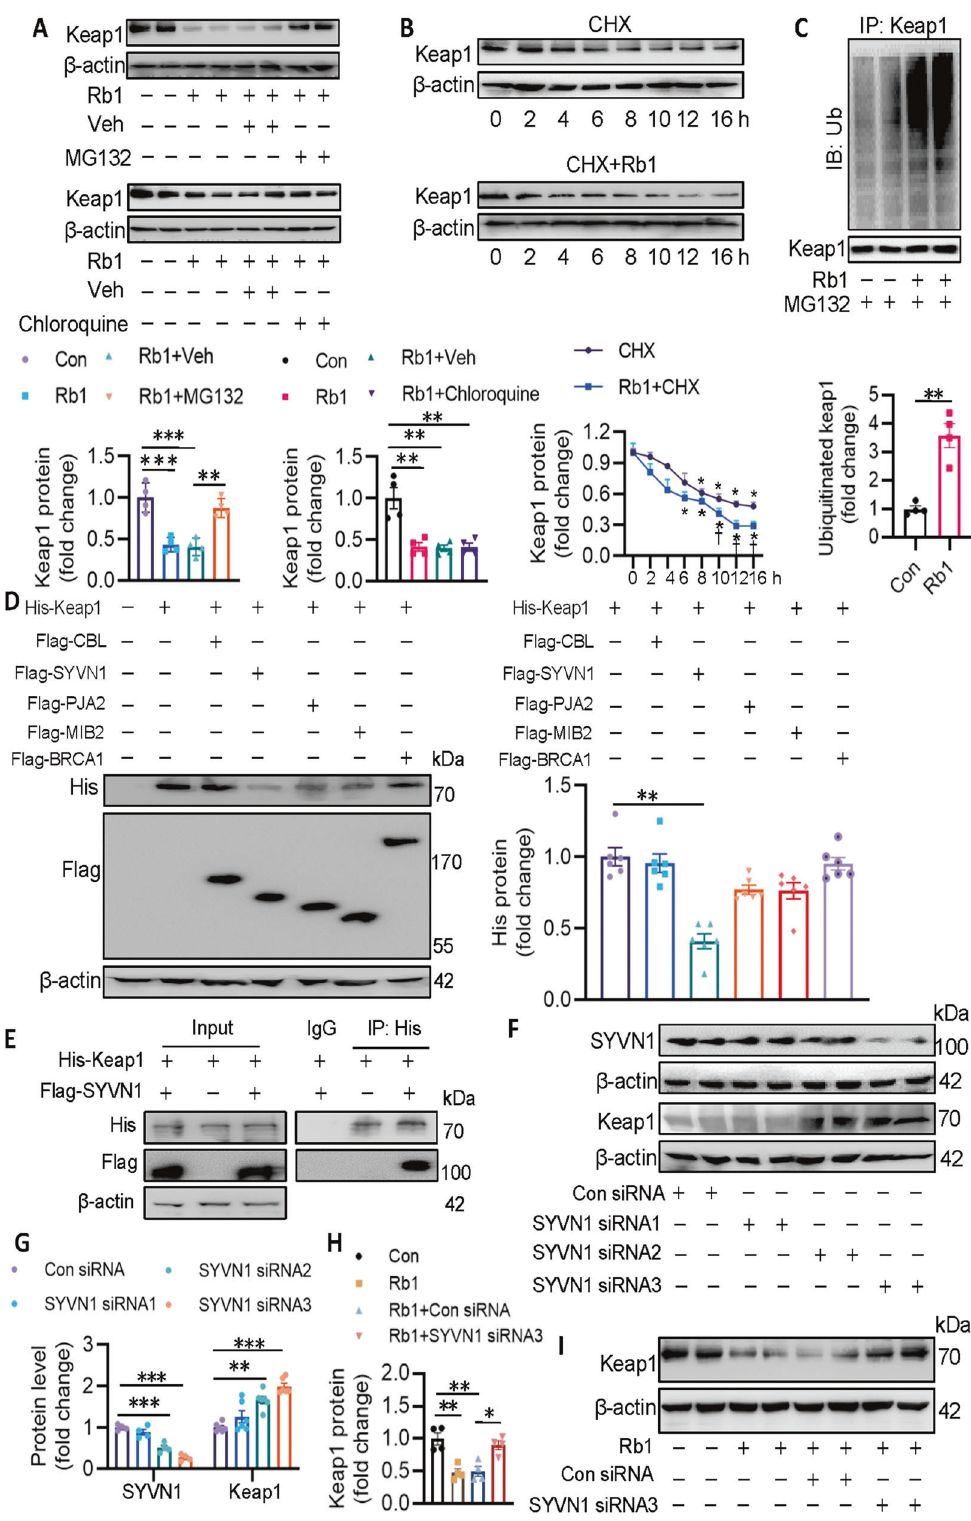
Fig. 5 SYVN1 is identi fi ed as the E3 ligase of Keap1 and mediates its degradation induced by Rb1. A MG132, but not chloroquine, reversed the effects of Rb1 on the protein level of Keap1. B Rb1 accelerated the degradation of Keap1 in the presence of CHX. C Rb1 accelerated the ubiquitination of Keap1. D HEK293T cells were transfected with required plasmids for 48, and cell lysates were immunoblotted to quantify His- Keap1 protein levels. E The interaction of Keap1 with SYVN1 was detected by immunoprecipitation. F , G EA.hy926 ECs were transfected with different siRNAs against SYVN1 for 72 h. Cell lysates were immunoblotted to quantify SYVN1 and Keap1 protein levels. H , I SYVN1 siRNA3 blocked the suppressive effects of Rb1 on Keap1 protein levels in ECs. Data are presented as mean ± SEM. n = 4 – 6. Statistical analysis was performed with the randomized block ANOVA. * P < 0.05; ** P < 0.01; *** P < 0.001; vs . indicated group.